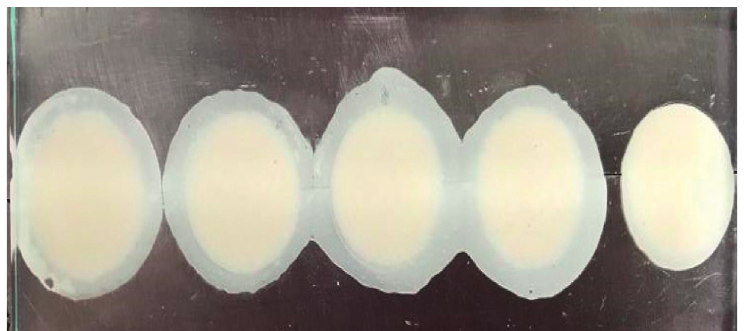
Figure 3: Autopolymerization of acrylic specimens.